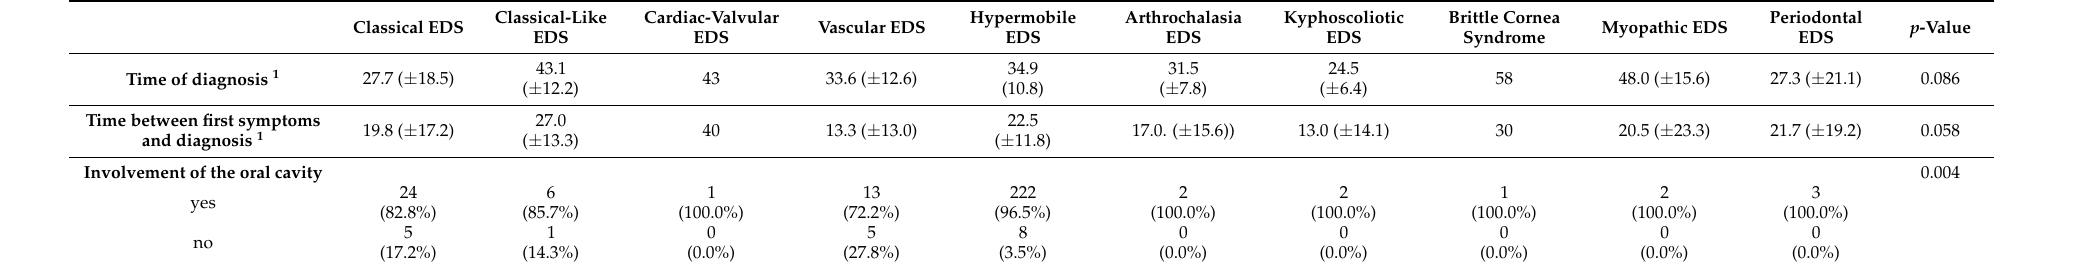
Table 4. Overview of the results from 3.5; p -values for categorical variables were calculated using a Chi-square test, and for continuous variables, a Kruskal-Wallis test was performed to calculate p -values; 1 = in